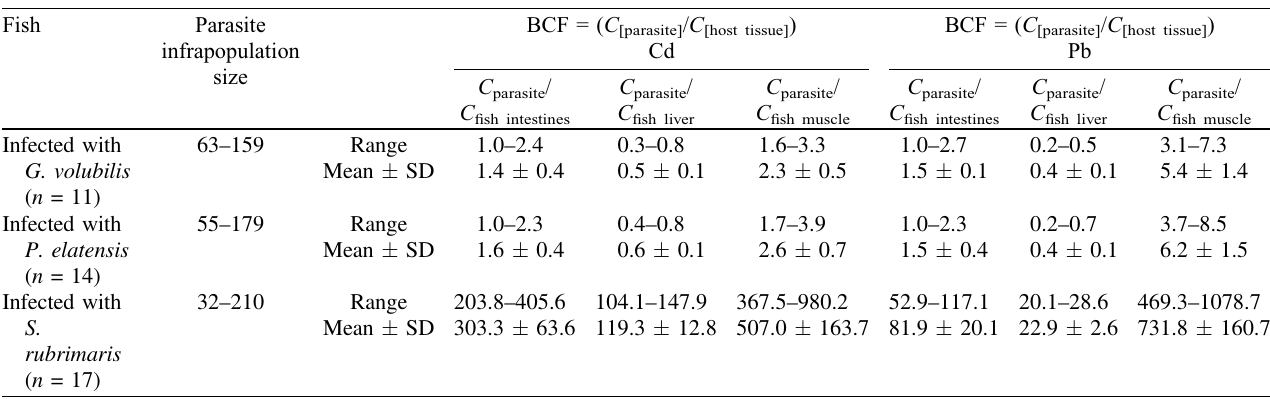
Table 4. Range and mean bioconcentration factors-BCF [= ( C [parasite] / C [host tissue] )] for Cd and Pb in 11, 14 and 17 infrapopulations of Gyliauchen volubilis , Procamallanus elatensis and Sclerocollum rubrimaris , respectively, calculated with respect to the selected host tissues. Fish Parasite